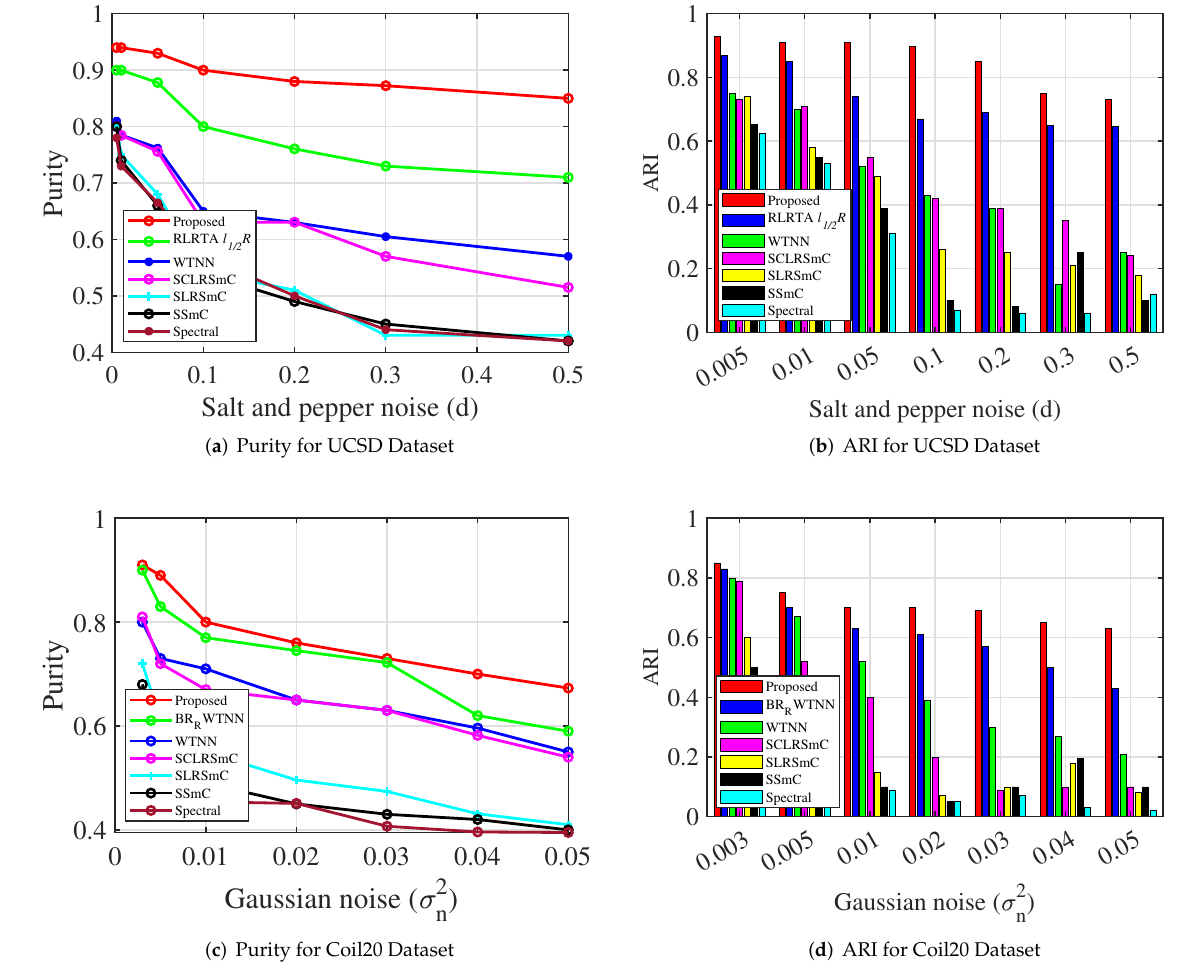
Figure 7. Quantitative Comparison ( a , b ): purity metric and ARI metric for UCSD dataset for various levels of salt and pepper noise. ( c , d ): purity metric and ARI metric for Coil20 dataset for various levels of Gaussian noise. of purity and ARI metrics of the proposed method and state-of-the art algorithms under salt and pepper noise ( d ) and Gaussian noise ( σ 2 n